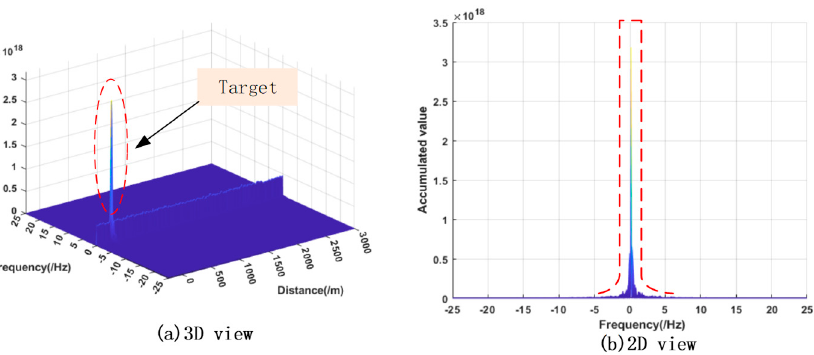
Figure 20. Target Energy Accumulation.